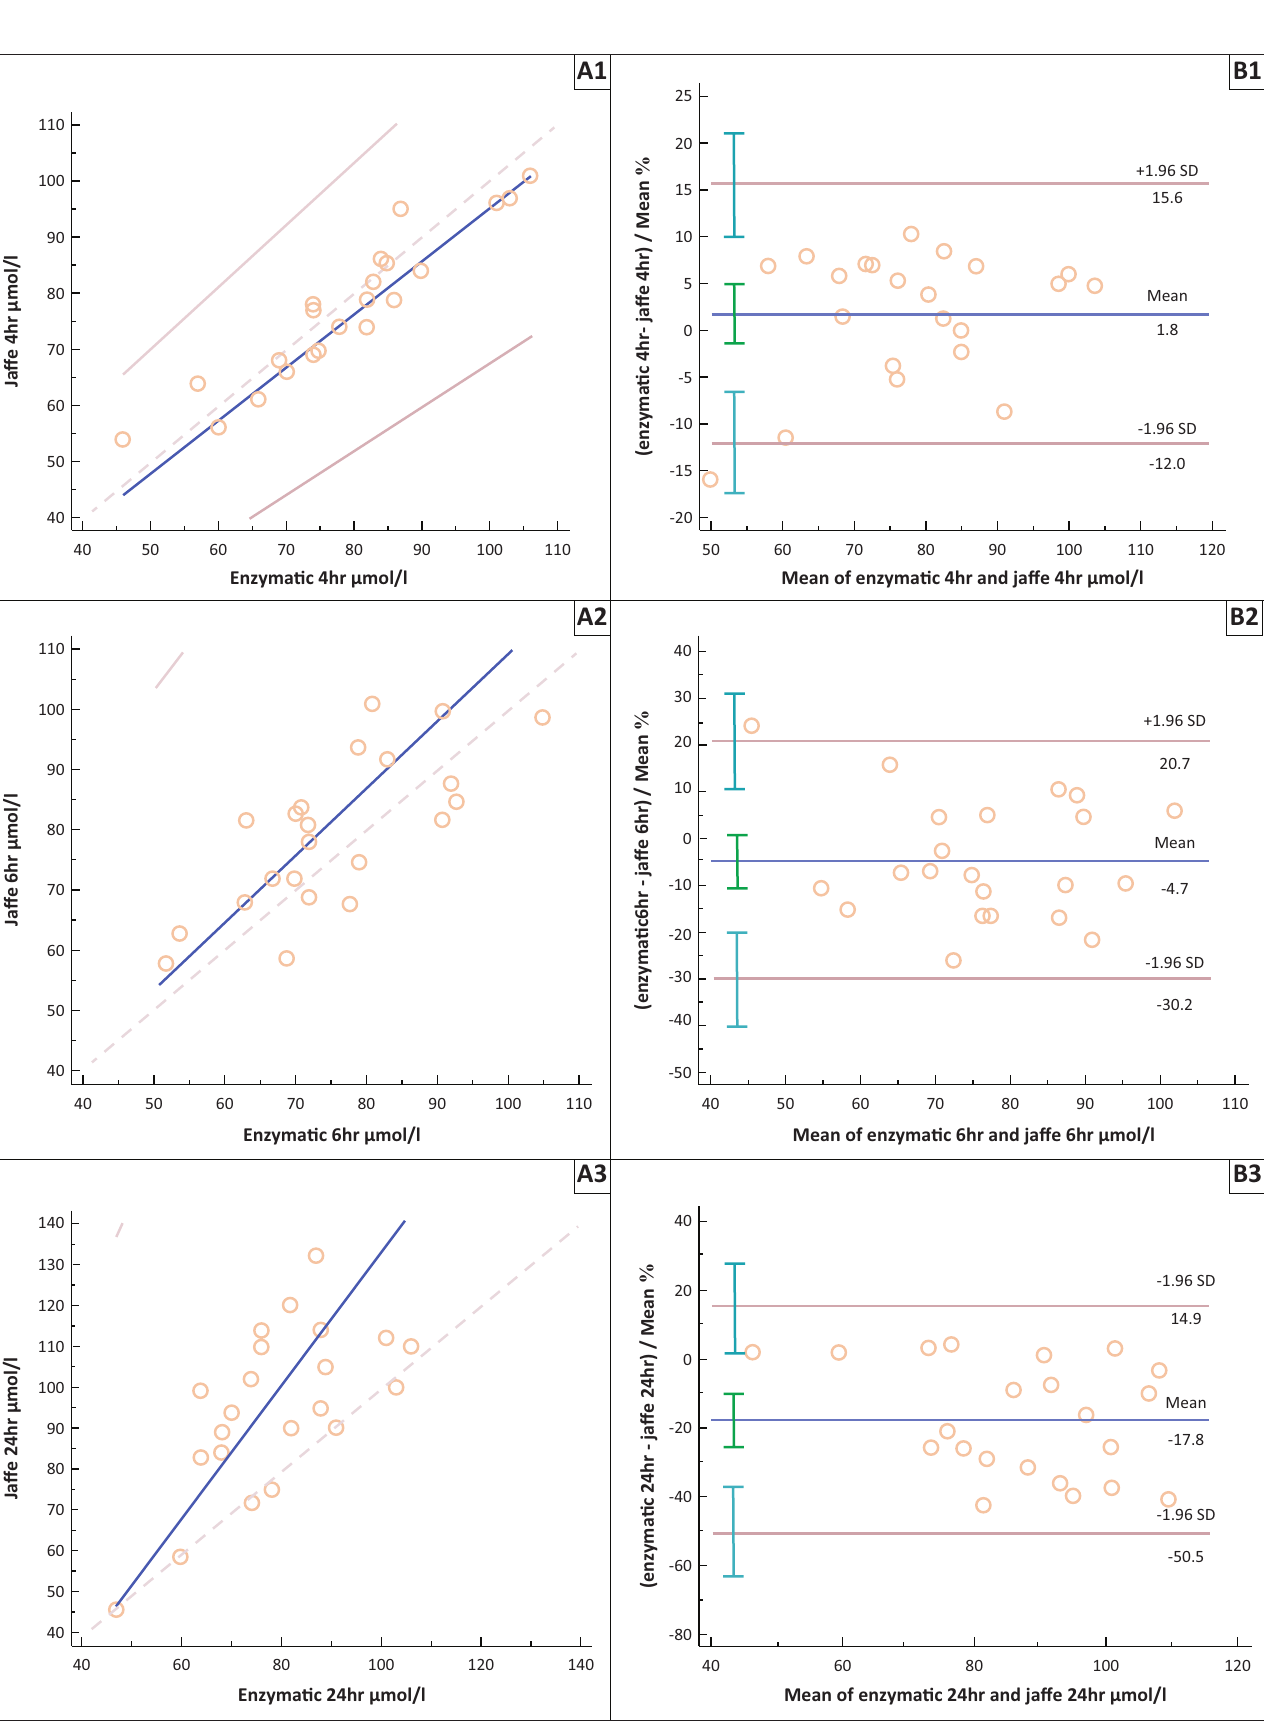
FIGURE 3: Passing-Bablok regression curves (A) and Bland-Altman plots (B) comparing creatinine concentrations from the kinetic Jaffe method with those from the enzymatic method. Creatinine concentrations at (1) < 4 h, (2) 6 h, (3) 24 h, (4) 48 h, (5) 72 h and (6) 96